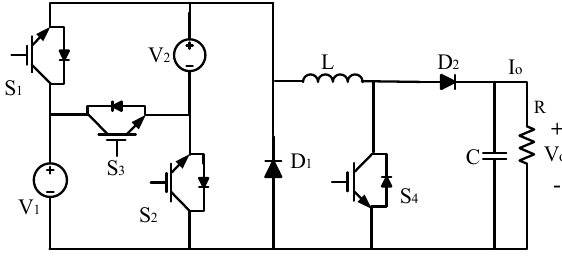
Figure 1. Basic circuit of the proposed modified bridge-type dual-input DC-DC (MBDC) converter for unidirectional operation.